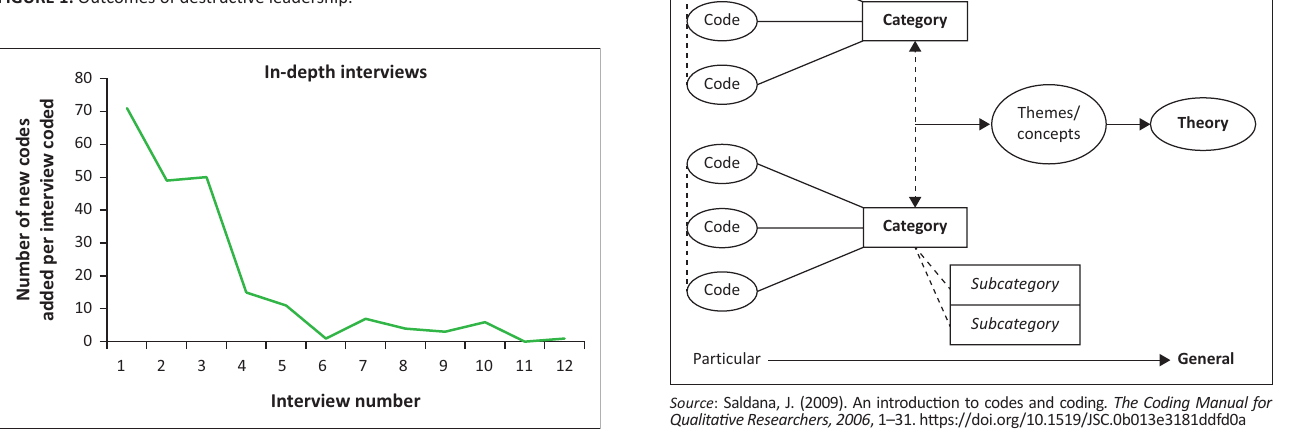
FIGURE 1: Outcomes of destructive leadership.